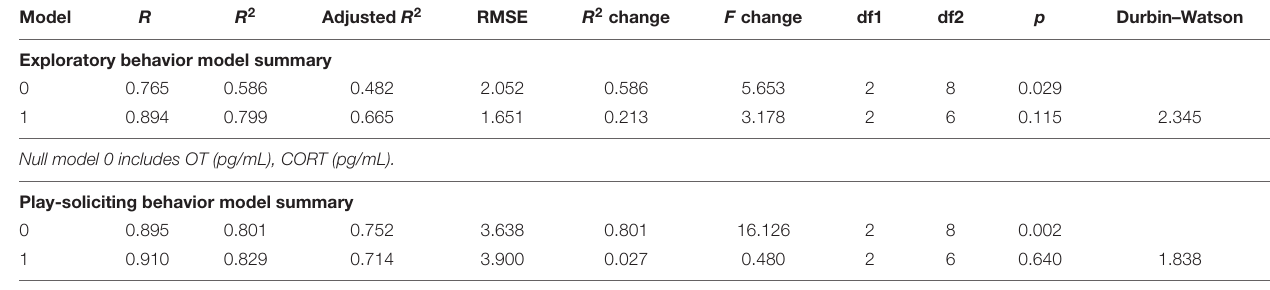
TABLE 3 | Hierarchical multiple regression models summary.